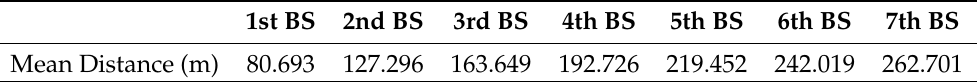
Table 1. Mean distance between each measurement point and neighboring